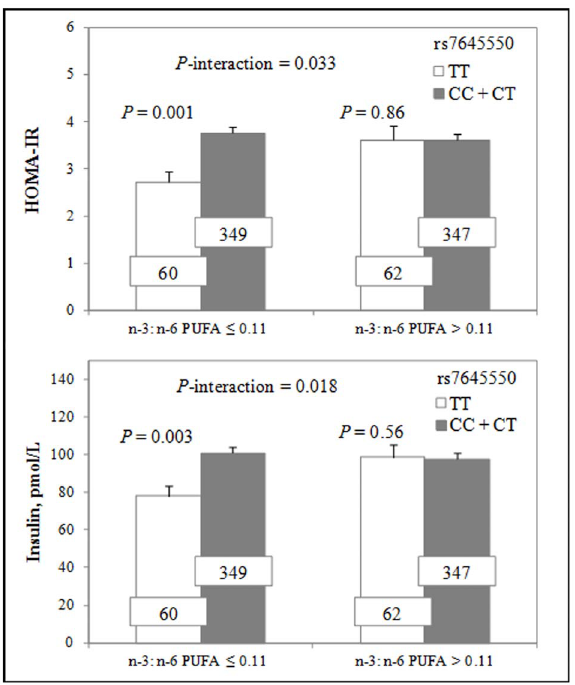
Figure 1. Interactions between rs7645550 and dietary n-3: n-6 PUFA ratio on HOMA-IR and insulin in GOLDN. When dietary n-3: n-6 PUFA ratio was low ( # 0.11), there were significant differences by genotypes for HOMA-IR ( P =0.001) and insulin ( P =0.003), while no significant differences for HOMA-IR ( P =0.86) and insulin ( P =0.56) were observed among the rs7645550 genotypes when dietary n-3: n-6 PUFA ratio was high ( . 0.11). The number inside the bar indicates the number of participants with a given genotype.